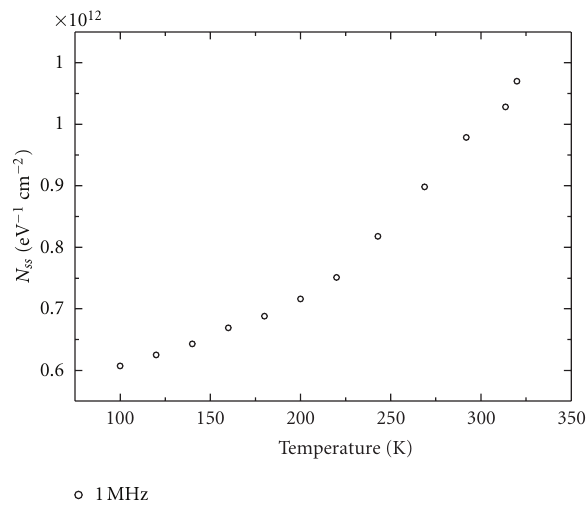
Figure 10: The interface states of the Al/HfO 2 /p-Si (MOS) structure as measured at 1MHz for various